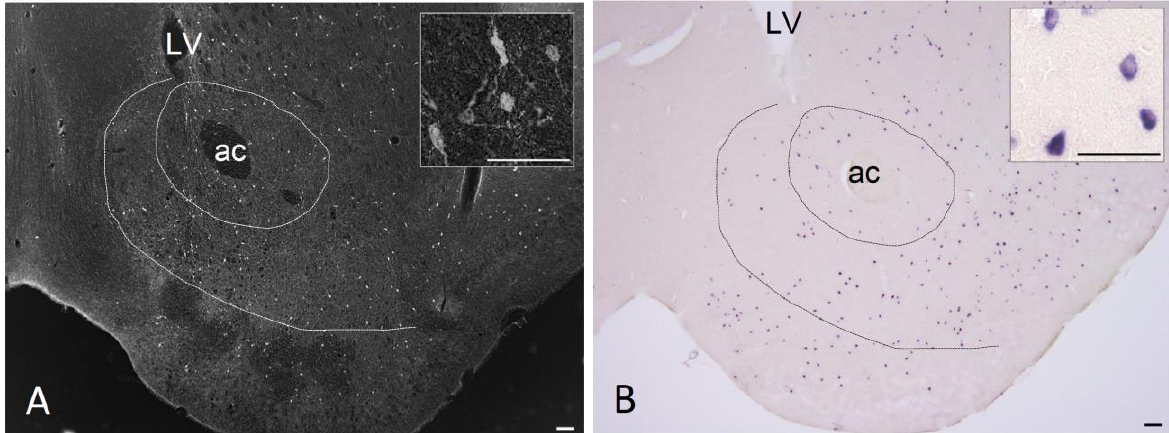
Figure 1. ( A ) Immunohistochemistry of NPY in the NAc of mice. Many medium-sized neurons with fibers are distributed in both the shell and core. Right upper panel shows a region-of-interest at an increased magnification. ( B ) In situ hybridization histochemistry of NPY mRNA by digoxigenin labeling. Dotted lines depict the medial to ventral border of the NAc and boundary between the core and shell. ac, anterior commissure. LV, lateral ventricle. Scale bars: 100 µ m in the main figures and 50 µ m in right upper panel.